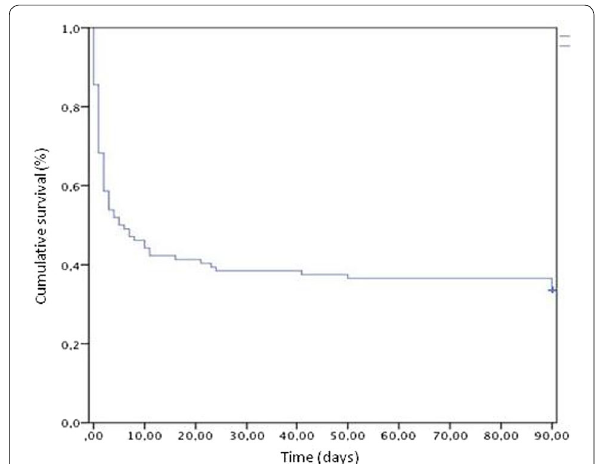
Fig. 2 Survival analysis at 90 days: Kaplan–Meier curve